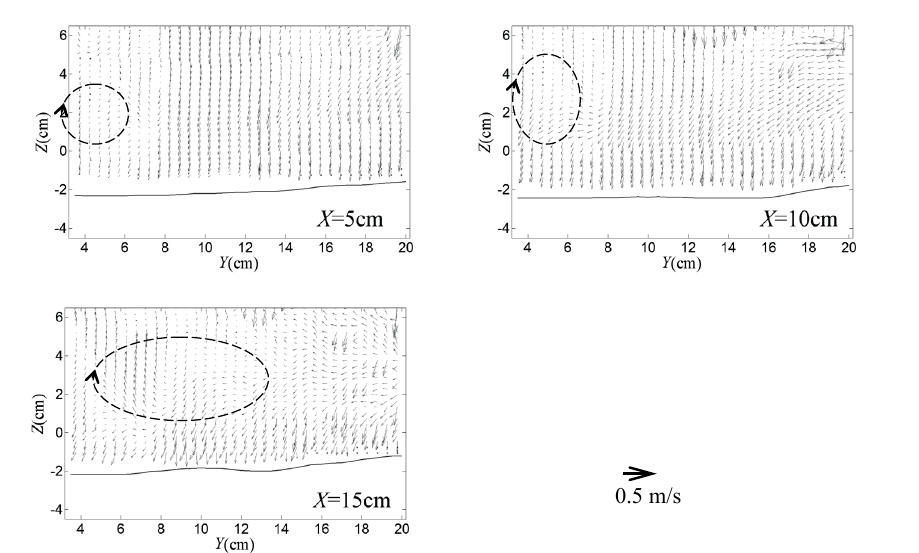
Fig. 5 . Vector plots of V t , NV